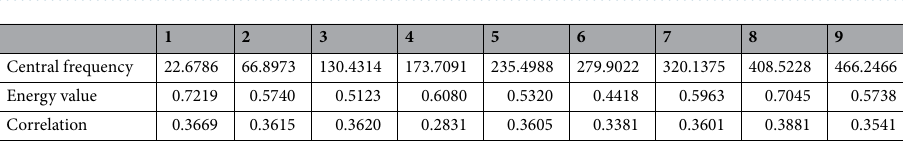
Table 4. The energy value and correlation of every